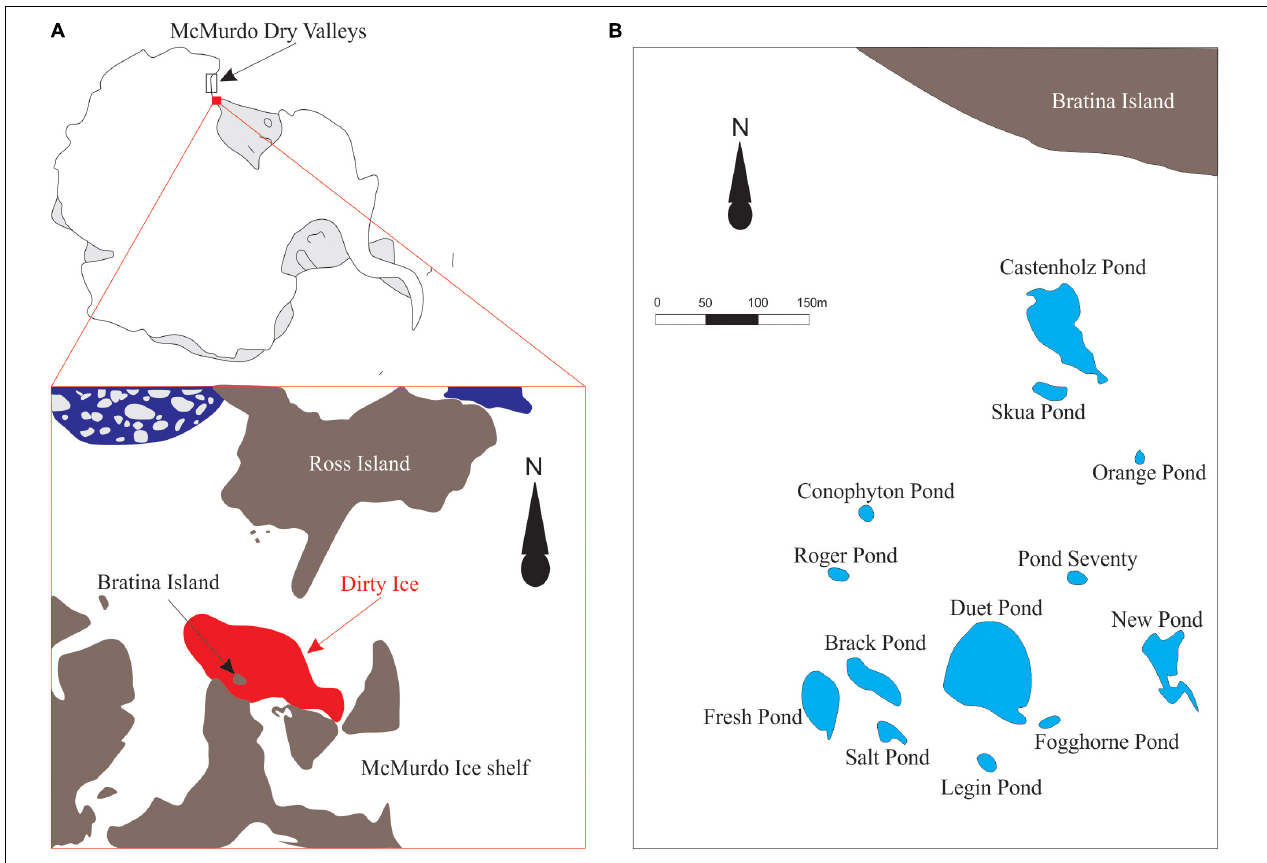
FIGURE 1 | (A) The schematic figure of the sampling location on the McMurdo Ice Shelf (78.00’S, 165.30’E). Microbial mats were collected from meltwater ponds on the ‘dirty ice’ marked in red. The figure was modified from Hawes et al. (2018). (B) Schematic map of the investigated meltwater ponds in the ‘dirty ice’ (modified from Jackson et al.,